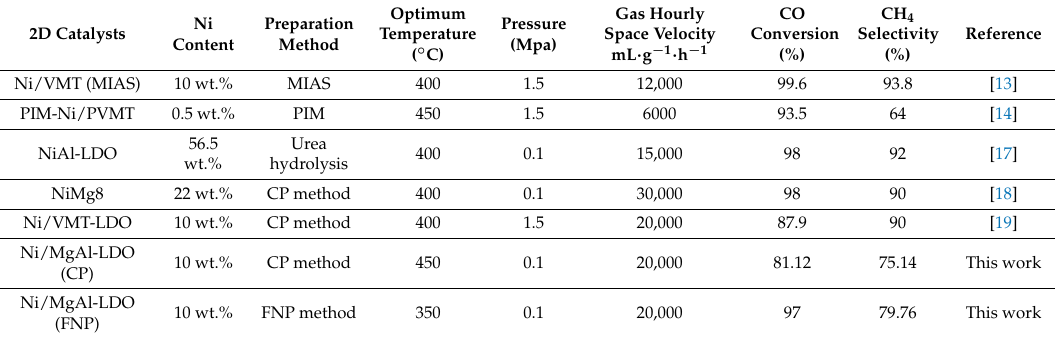
Table 1. Comparison of two-dimensional (2D) catalysts prepared via different methods. 2D Catalysts 2D